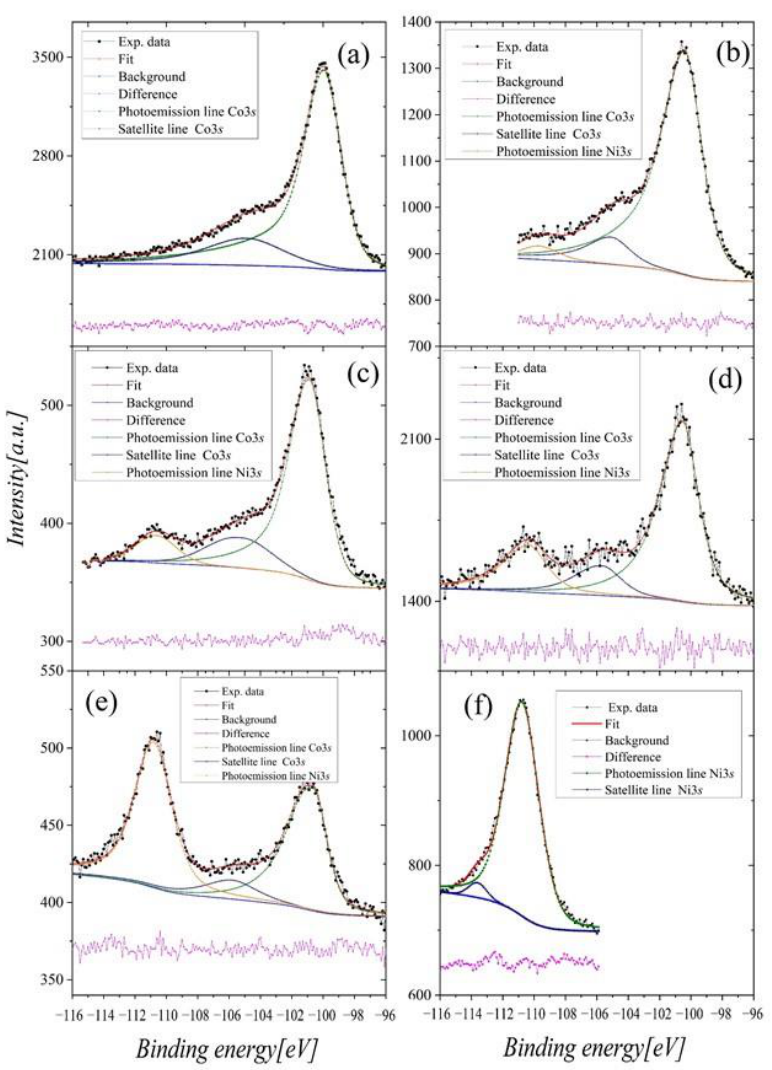
Figure 14. The splitting of the Co3 s and Ni3 s lines in Gd 0.4 Tb 0.6 (Co 1x Ni x ) 2 . The plots ( a )–( f ) concern samples with concentrations x = 0.0, 0.05, 0.10, 0.15, 0.50 and 1.0, respectively.